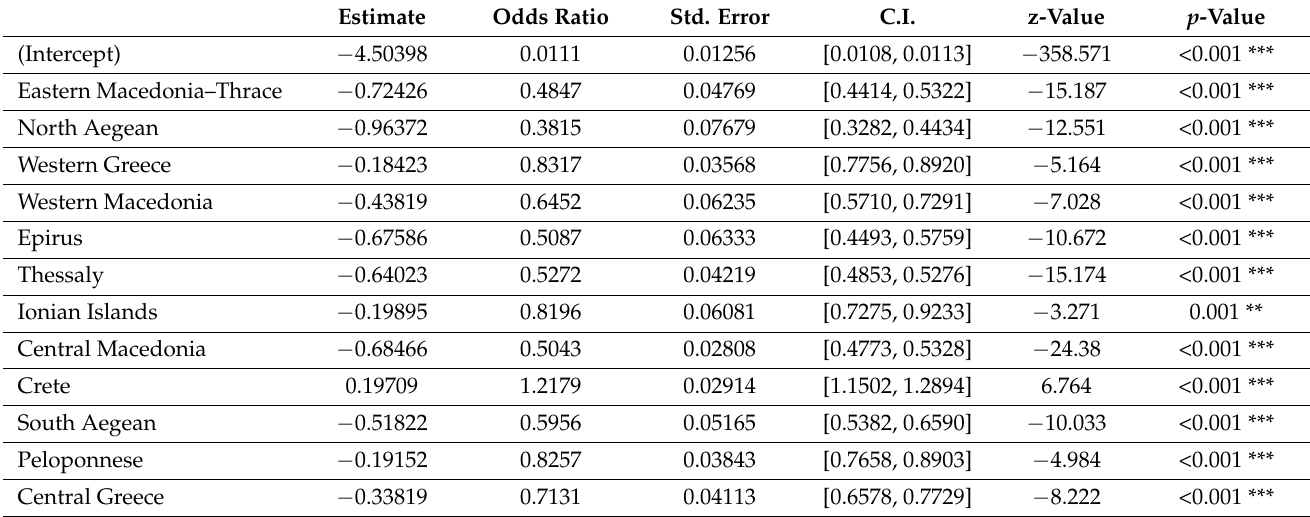
Table 3. Logistic regression coefficients; the region of Attica was used as reference.